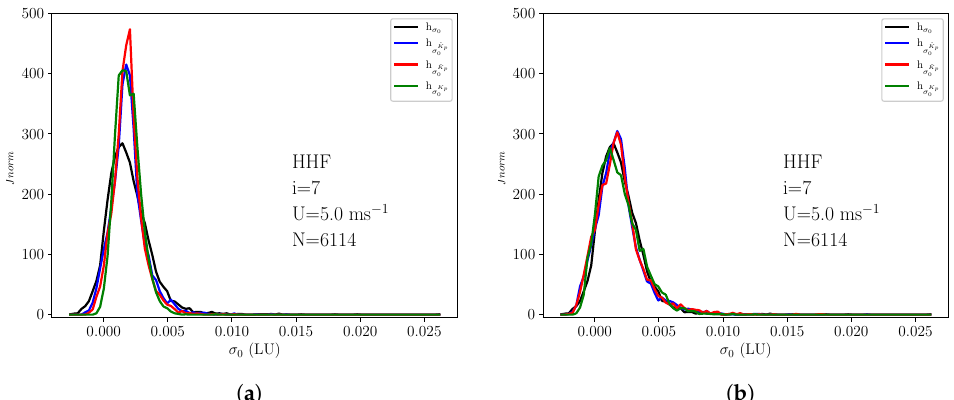
Figure 11. In each plot, the solid curve represents the normalized histogram of the real σ 0 s in linear units (LU) of the orbit with number 40,651, while the dashed (dotted) line represents the normalized histogram of the σ 0 s simulated using K EMP p ( K MED p ) in the random generator described in Equation (5). Finally, the dashed–dotted curve shows the simulated σ 0 s obtained using product K p s. Some additional information is reported in each panel, describing the case under examination: the flavor (pol; view) , the slice index, the reference wind speed value and the total number of samples, respectively. The flavor string is composed as follows: HH (VV) stands for HH-Pol (VV-Pol) and A (F) stands for aft (fore). In the right plot, K p s (and so K MED p ) and K EMP p are multiplied by 1.70 and 1.40,